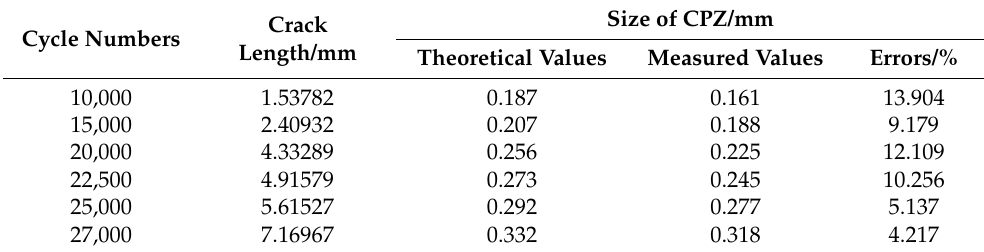
Table 3. Measurement results and theoretical results of CPZ in Q&P980 steel.